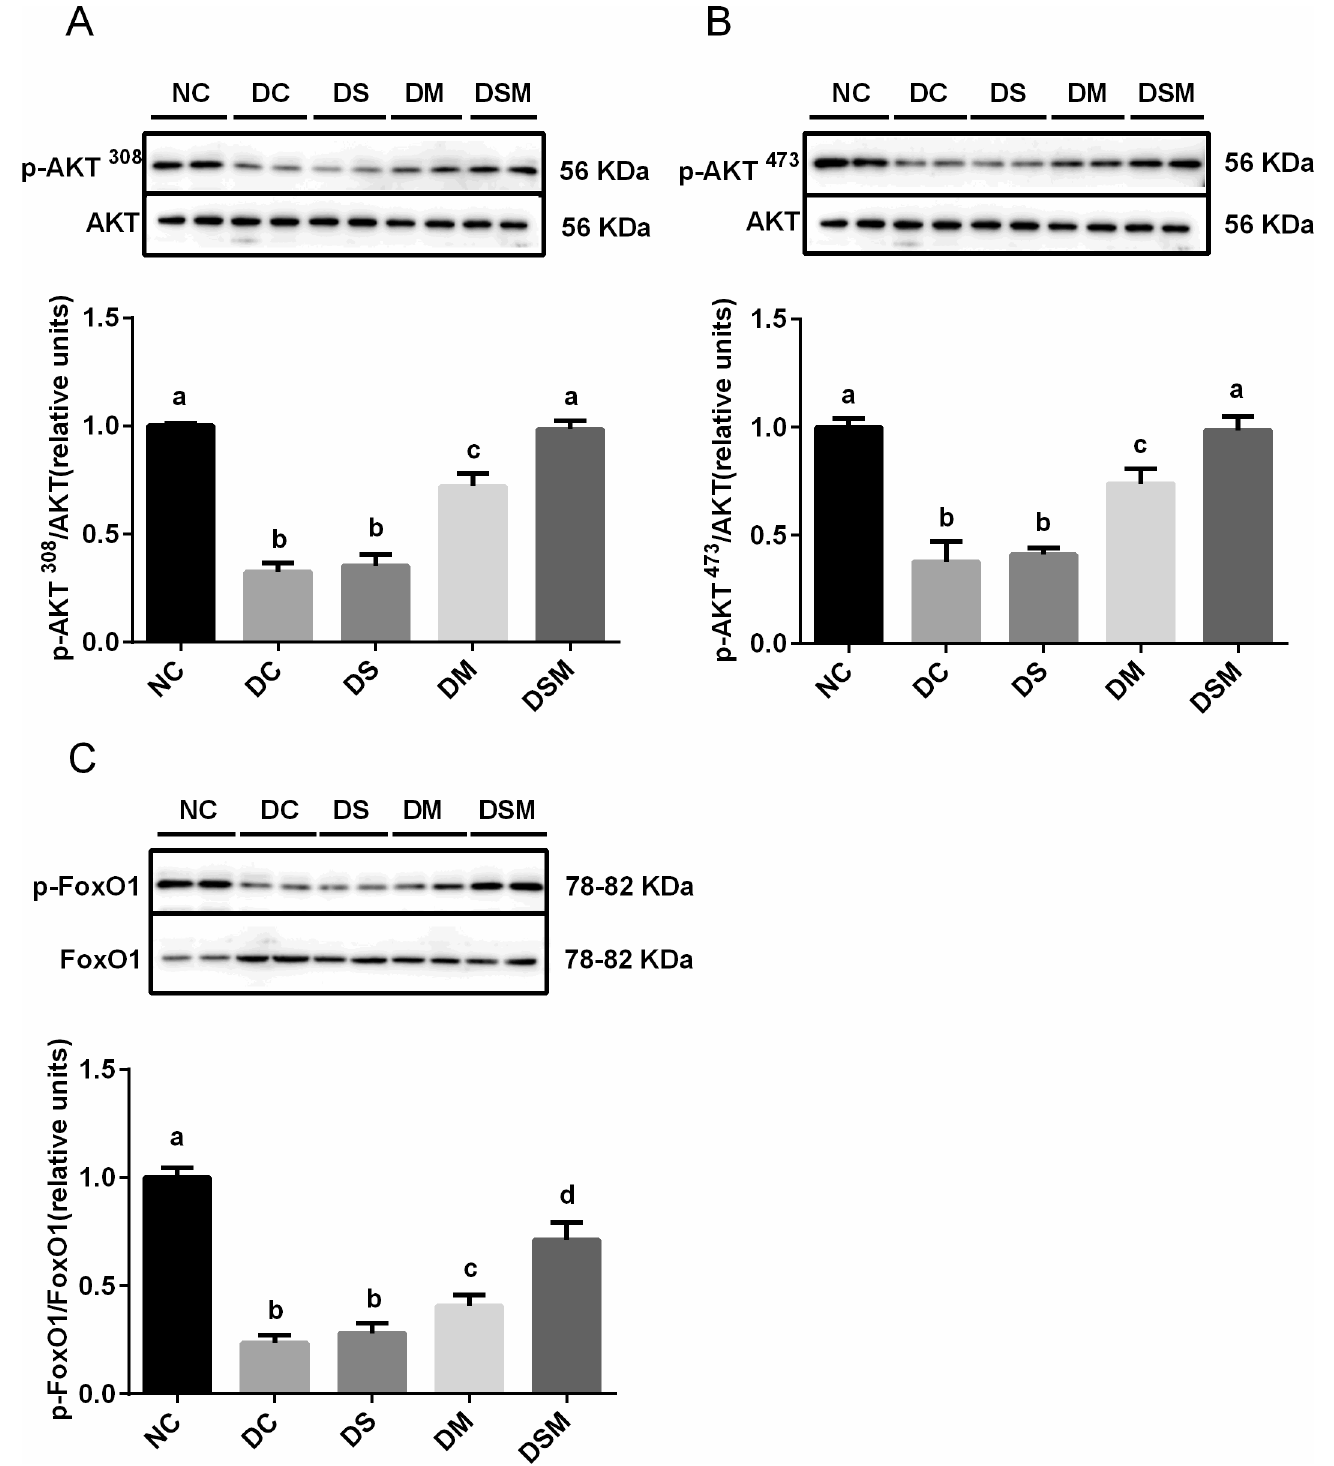
Fig 3. Intervention by swimming plus metformin normalizes the hepatic insulin sensitivity under GDM condition. Levels of AKT Thr308 phosphorylation (p- AKT T308) were normalized to total AKT in the livers treated with swimming or metformin or both combined. (B) Levels of phosphorylated serine-473 AKT (p- AKT S473) were normalized to total AKT in the livers treated with swimming or metformin or both combined. (C) Levels of phosphorylated FoxO1 were normalized to total FoxO1 in the livers intervened by swimming or metformin or both combined. The values represent the mean ± SEM, n = 10/group. The